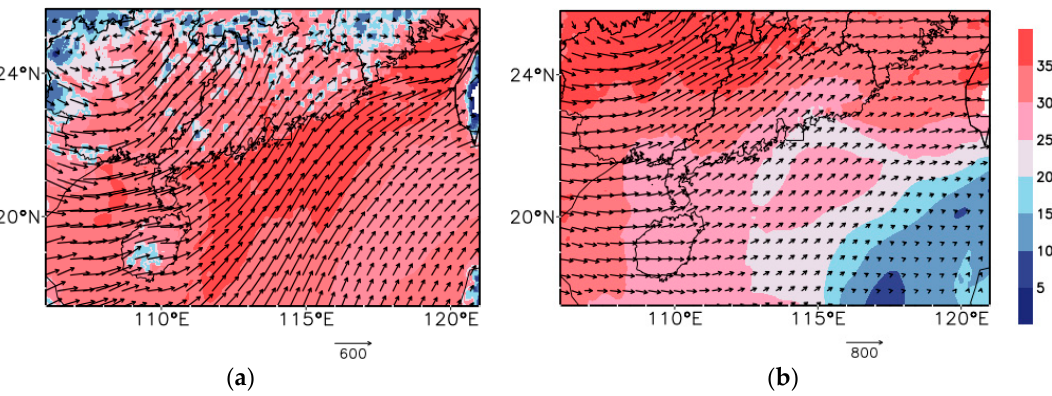
Figure 9. Vertically integrated humidity (shading; mm) and water vapor flux (vectors; kgm − 1 s − 1 ) ( a ) below 800 hPa and ( b ) above 800 hPa from the D2 simulation at 0000 UTC on 20 May 2015.